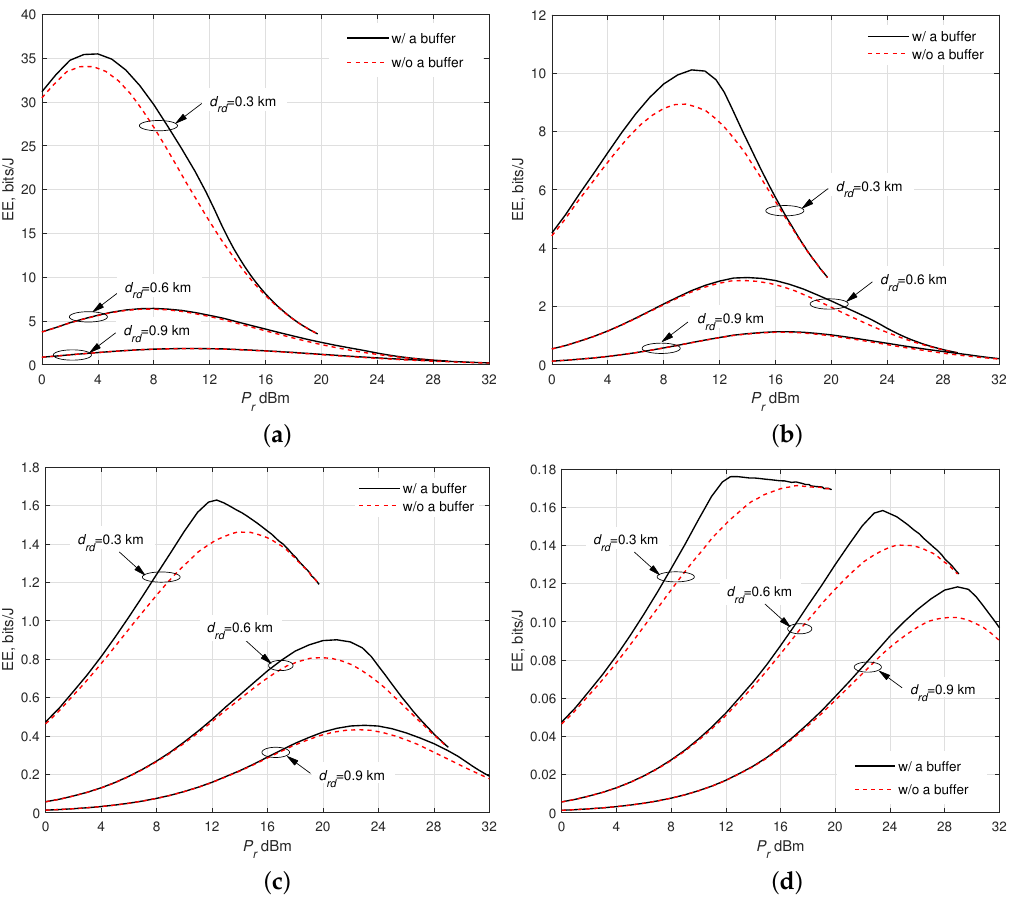
Figure 5. EE across P r when P s = 23 dBm, d sr = 0.6 km, d rd ∈ { 0.3,0.6,0.9 } km, and η = 5.26. ( a ) P c = 10 dBm. ( b ) P c = 20 dBm. ( c ) P c = 30 dBm. ( d ) P c = 40